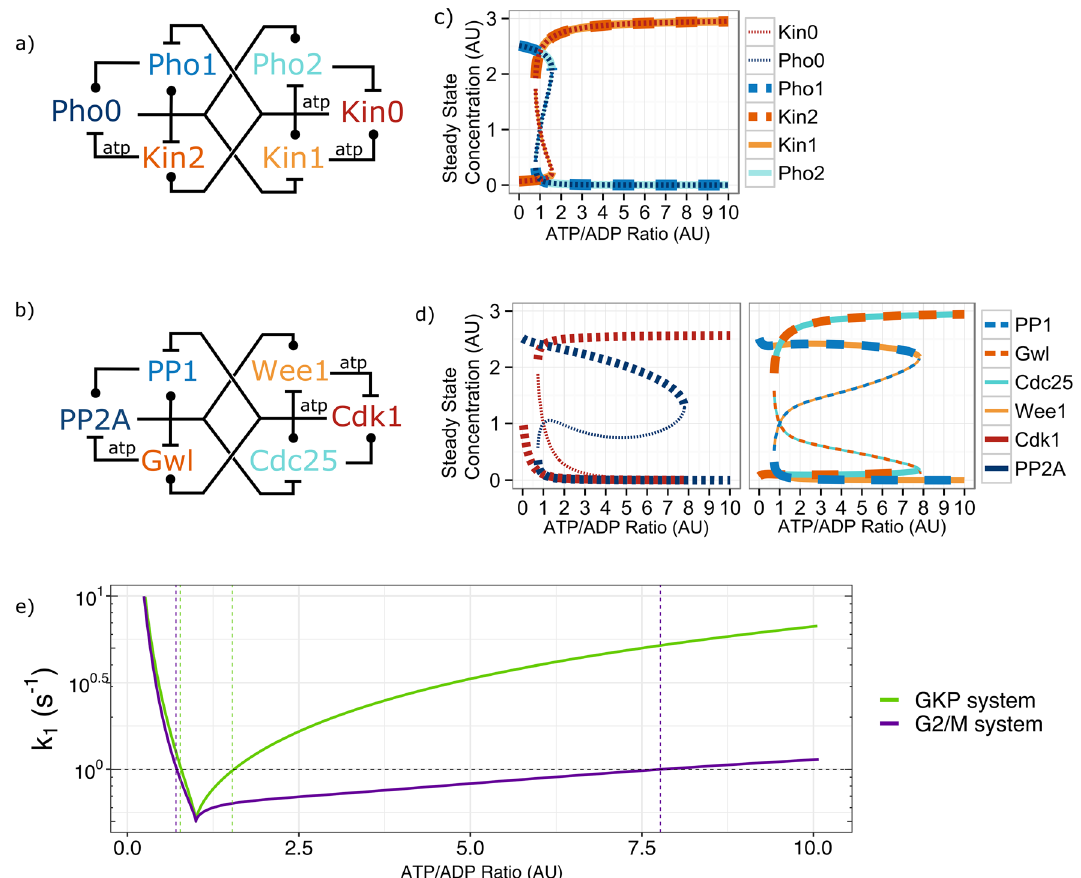
Figure 2. Dynamical analysis of General Kinase-Phosphatase (GKP system) and the mitotic entry network (G2/M system) driven by ATP. ( a ) Wiring diagram of the General Kinase-Phosphatase (GKP). Molecules grouped by biochemical function: blue scale phosphatases; orange scale kinase. Ball-end edges indicate activation; dash-end edges indicate inhibition. ( b ) Wiring diagram of the G2/M regulatory system (notations as on panel a). The atp label indicates the reactions which require these molecules. ( c ) Bifurcation diagram of the GKP system. It represents the steady-state concentration of the noted molecules at various ATP/ADP ratios. The system is bistable in the regime 0.77 < ATP/ADP < 1.53. ( d ) Bifurcation diagrams of the G2/M regulatory system representing the steady-state concentration of the molecules at various ATP/ADP ratios. Stable steady states labelled with thick, unstable steady states with thin dashed lines to allow the visualisation of overlapping curves. The system is bistable in the regime 0.71 < ATP/ADP < 7.77. The left-side panel shows the behaviour of Cdk1 and PP2A, while the right-side panel shows the rest of the species (Gwl, PP1, Wee1 and Cdc25) ( e ) Two-dimensional bifurcation diagram of the GKP and G2/M systems, showing how the bistable region changes as the rate of reactions (k 1 ) is changed from the baseline k1 = 1, which was used to plot panels c and d. The vertical dashed lines indicate the bistable region for the GKP and the G2/M systems (green and purple, respectively) at this k 1 level. See supplementary methods for details on the calculation of these curves. Graphics were obtained using R version 3.6 and ggplot2 37,38 . For panel e, Oscill8 45 was